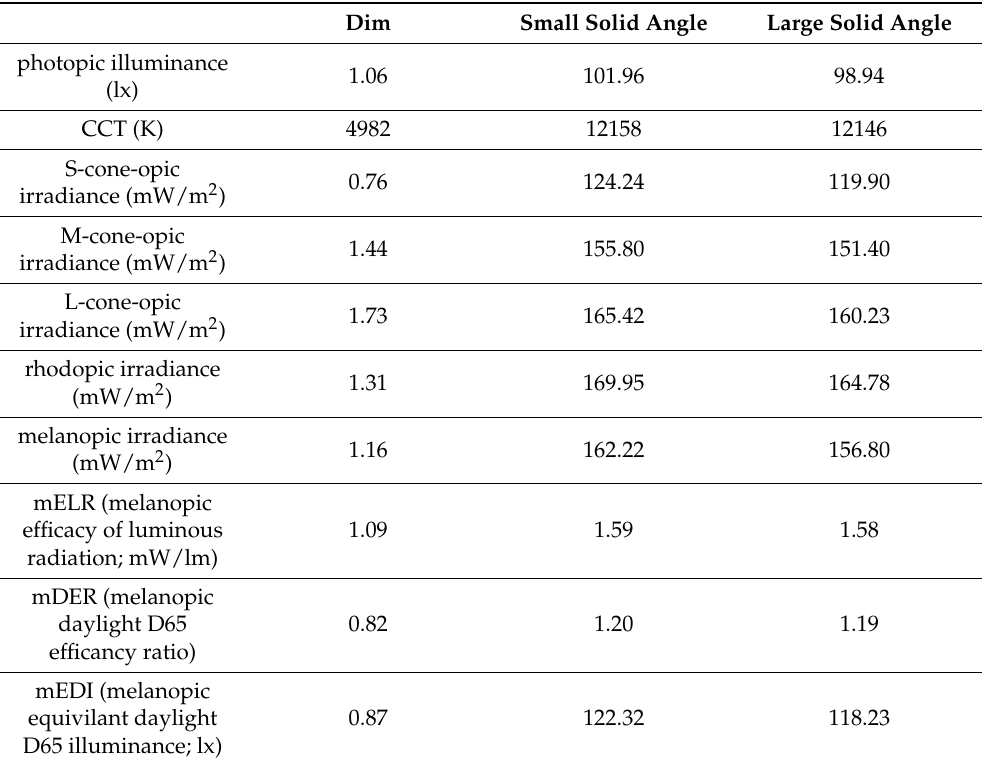
Table A1. Illuminance, CCT, α -opic irradiances, melanopic efficacy of luminous radiation,